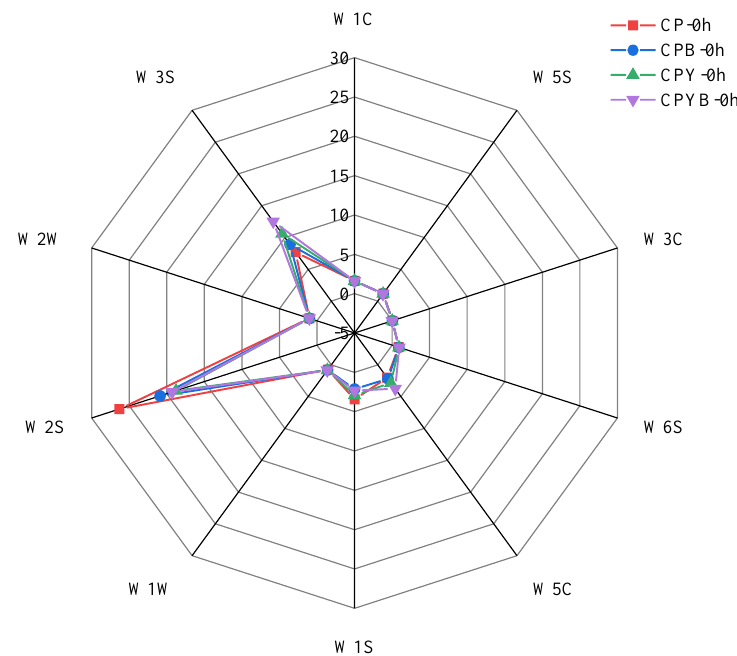
component analysis (PCA) was conducted in this research.